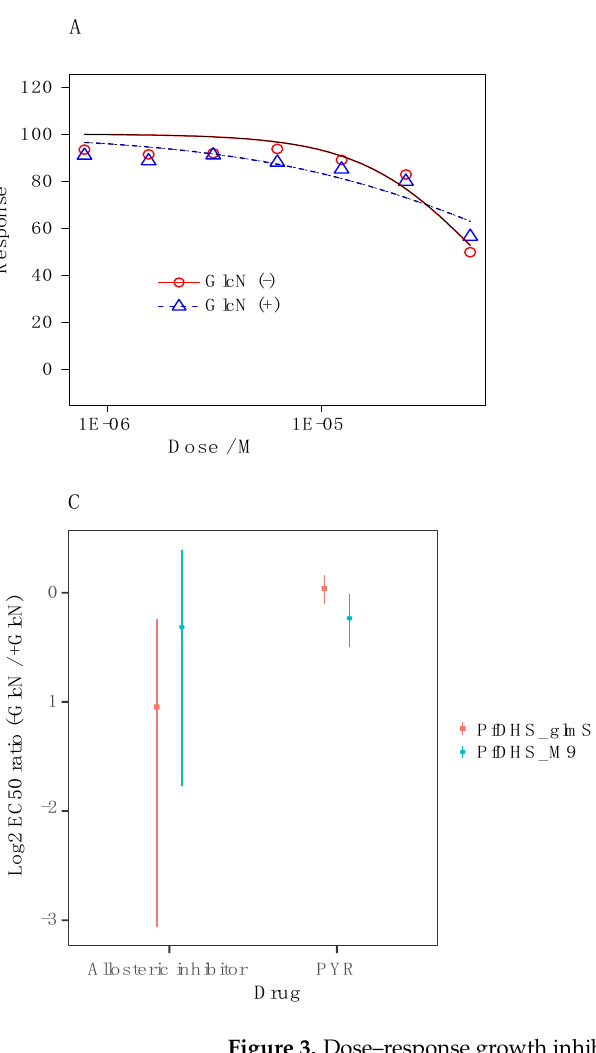
Figure 3. Dose–response growth inhibition curves with the allosteric inhibitor 6-bromo- N -(1 H -indol-4yl)-1-benzothiophene-2-carboxamide against: ( A ) Transgenic Pfdhs _ glmS parasites and ( B ) ribozyme-inactive transgenic Pf DHS_M9 parasites with cotreatment of 2.5 mM glucosamine (GlcN) (blue triangles) or without co-treatment (red circles). ( C ) The estimated log 2 ratio of EC 50 between the +GlcN (blue points) and −GlcN (red points) conditions together with CI 95 is shown for the allosteric inhibitor and the pyrimethamine control in transgenic parasites, i.e., Pfdhs _ glmS and the inactive mutant. p -Values comparing log 2 EC 50 (−GlcN/+GlcN) estimate: 0.58 Pfdhs _ glmS (pyrimethamine): 1 × 10 −4 Pfdhs _M9 (pyrimethamine); 0.81 Pfdhs _ glmS (allosteric inhibitor); 4 × 10 −8 Pfdhs _M9 (allosteric inhibitor).